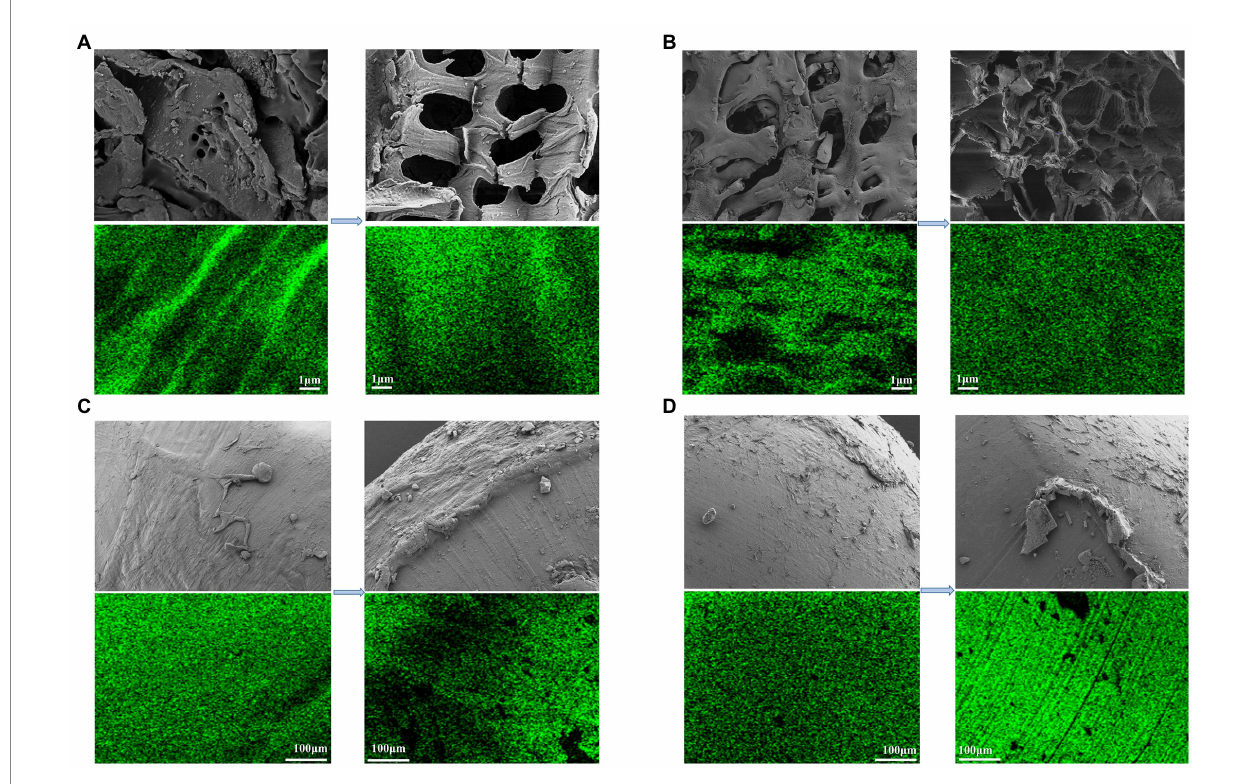
FIGURE 4 Distribution of SEM images and C of each carbon source before and after carbon released. (A) RS; (B) CC; (C) PCL; (D)